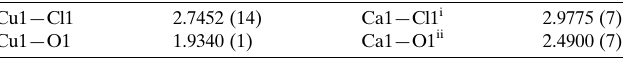
Table 1 Selected bond lengths (A˚ ).